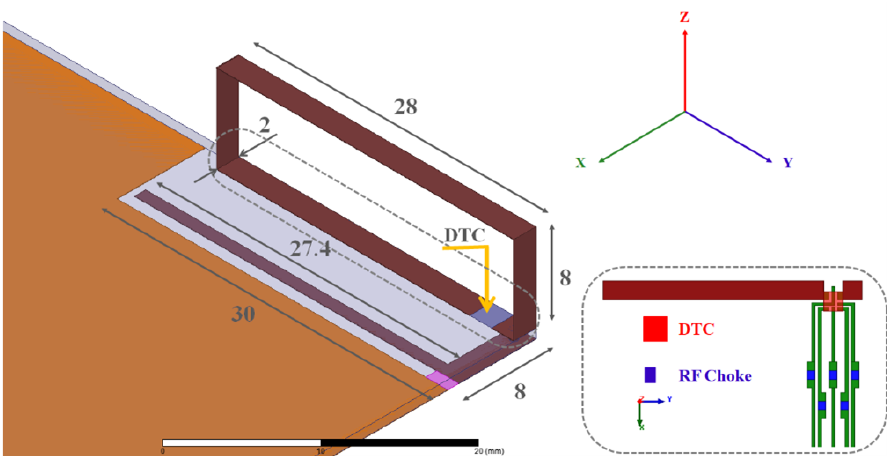
Figure 1. Antenna